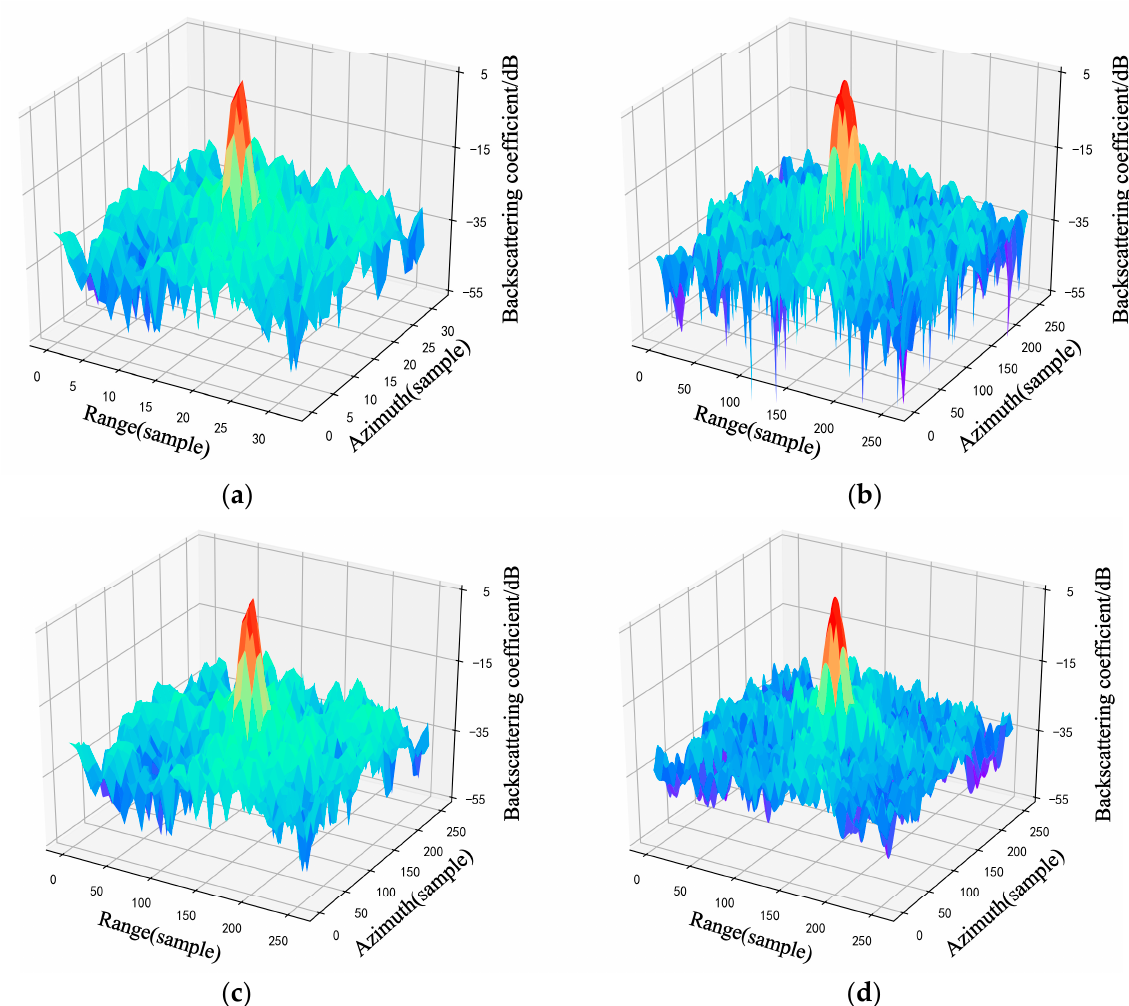
Figure 8. The backscattering coefficient image of CR-1 and the two-dimensional interpolation results using Sinc, Bilinear and FFT method. ( a ) Raw backscattering coefficient data; ( b ) Sinc interpolation results of SLC data; ( c ) Bilinear interpolation results of the backscattering coefficient; ( d ) FFT interpolation results of the backscattering coefficient.